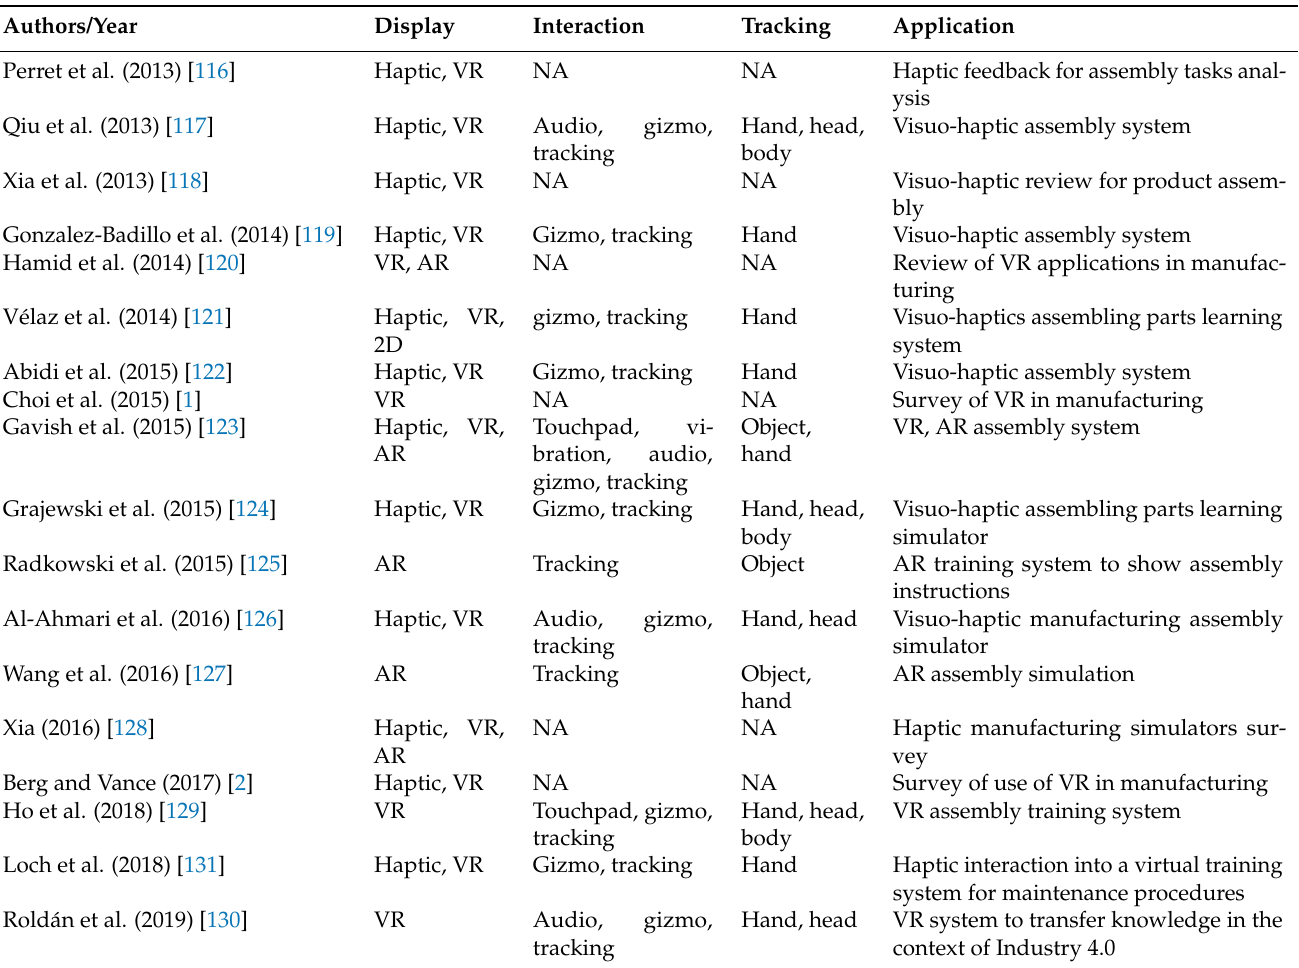
Table 8. Data table of the industry